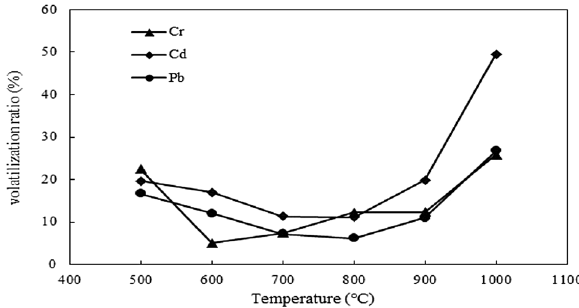
Table 3. The EFs of Cr, Cd, and Pb first increased and then